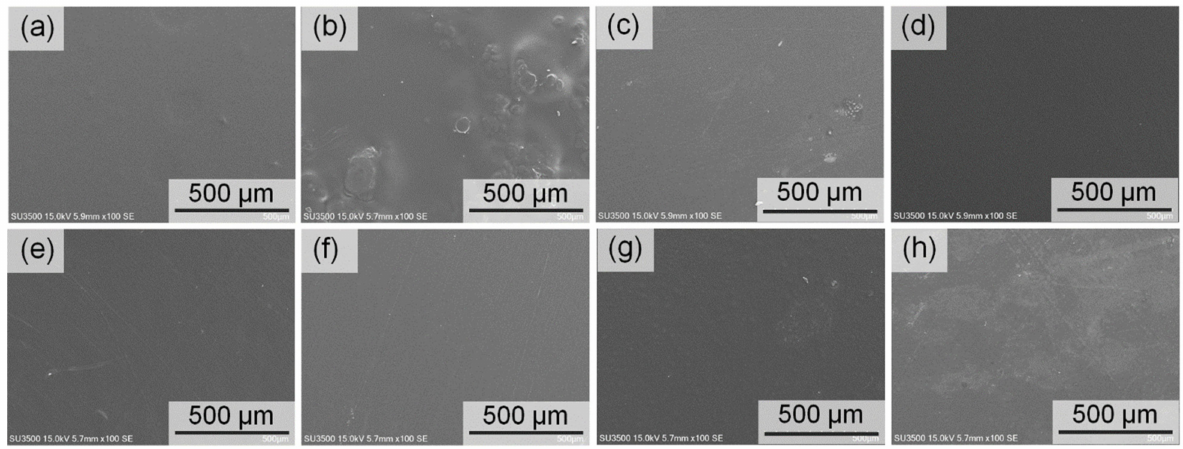
Figure 7. SEM images of the ( a ) neat PLA, ( b ) PLA/CNF, ( c ) PLA/CNFa2, ( d ) PLA/CNFa4, ( e ) PLA/CNFp2, ( f ) PLA/CNFp4, ( g ) PLA/CNFb2, and ( h ) PLA/CNFb4 composite